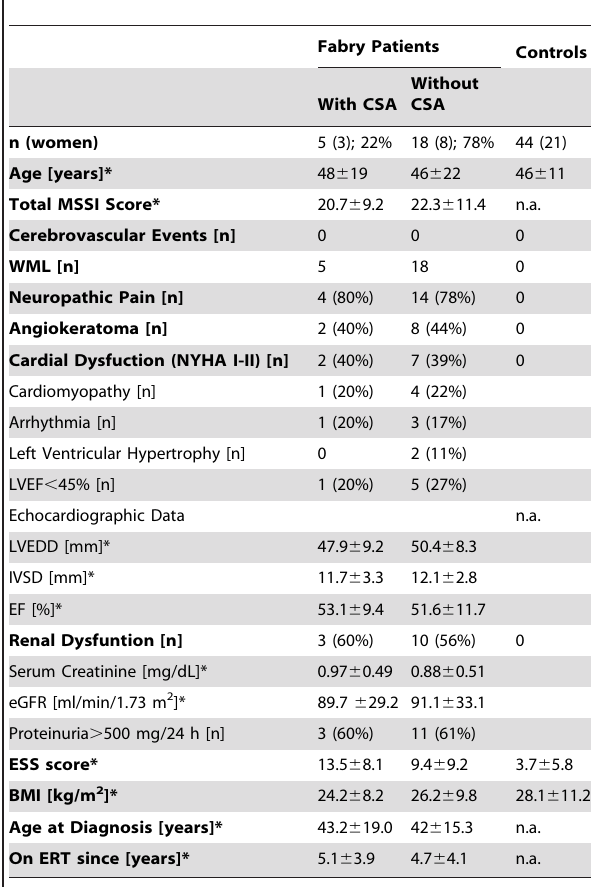
Table 1. Demographic and clinical characteristics of patients and